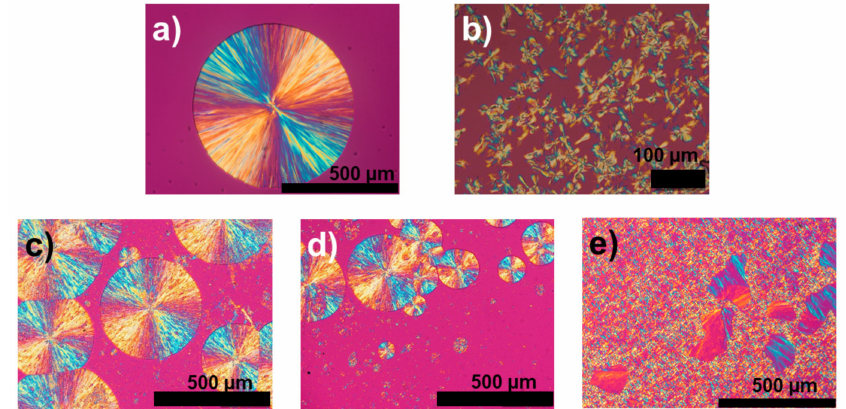
Figure 3. PLOM micrographs obtained during isothermal crystallization at 40 ◦ C. ( a ) PEO, ( b ) PHD, ( c ) 80/20 PEO/PHD blend, ( d ) 50/50 PEO/PHD blend, and ( e ) 20/80